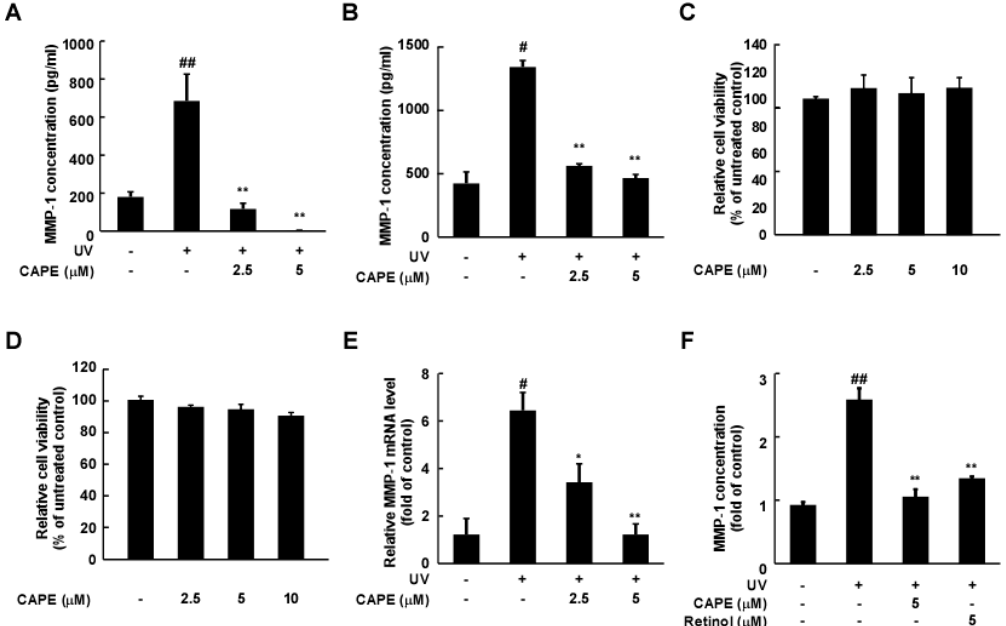
Figure 2. Effect of caffeic acid phenethyl ester (CAPE) on UV-induced MMP-1 in human dermal fibroblasts. Primary human dermal fibroblast (HDF) and Human foreskin fibroblast (Hs68) cells were pre-treated with CAPE for 1 h before being exposed to UV. ( A , B ) After 48 h, MMP-1 production in cultured media was measured using ELISA ( n = 3). ( C , D ) Cell viability was measured after cells were treated with CAPE for 48 h ( n = 4). ( E ) MMP-1 mRNA levels were determined using real-time PCR ( n = 5). ( F ) MMP-1 production in cultured media was measured using ELISA ( n = 3). The data are expressed as mean ± SD. # p < 0.05 and ## p < 0.01 versus untreated control; * p < 0.05 and ** p < 0.01 versus the group exposed to UV alone.